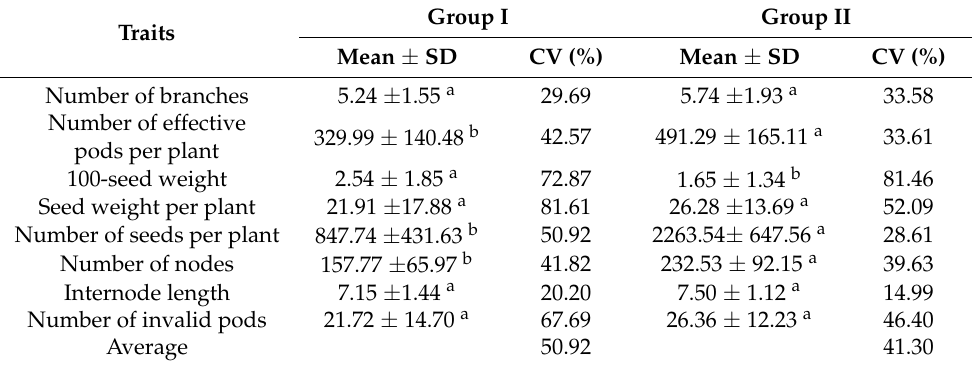
Table 7. Cluster analysis in agronomic traits in 242 wild soybean samples based on the mean data of the years of 2012 and 201). Data are presented as mean ± standard deviation. CV, coefficient variation.